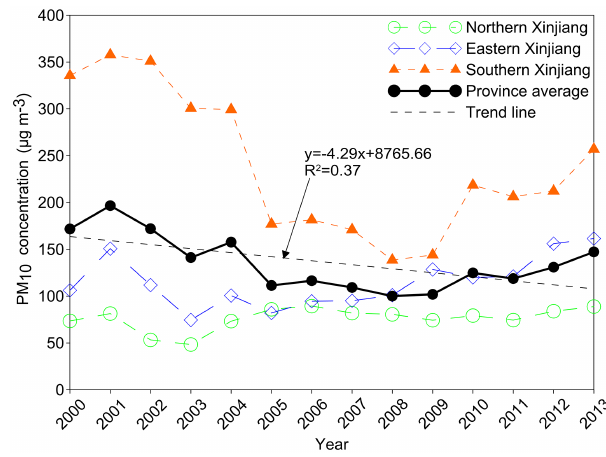
Figure 6. Annual average PM 10 concentration in Xinjiang Province from 2000 to 2013.